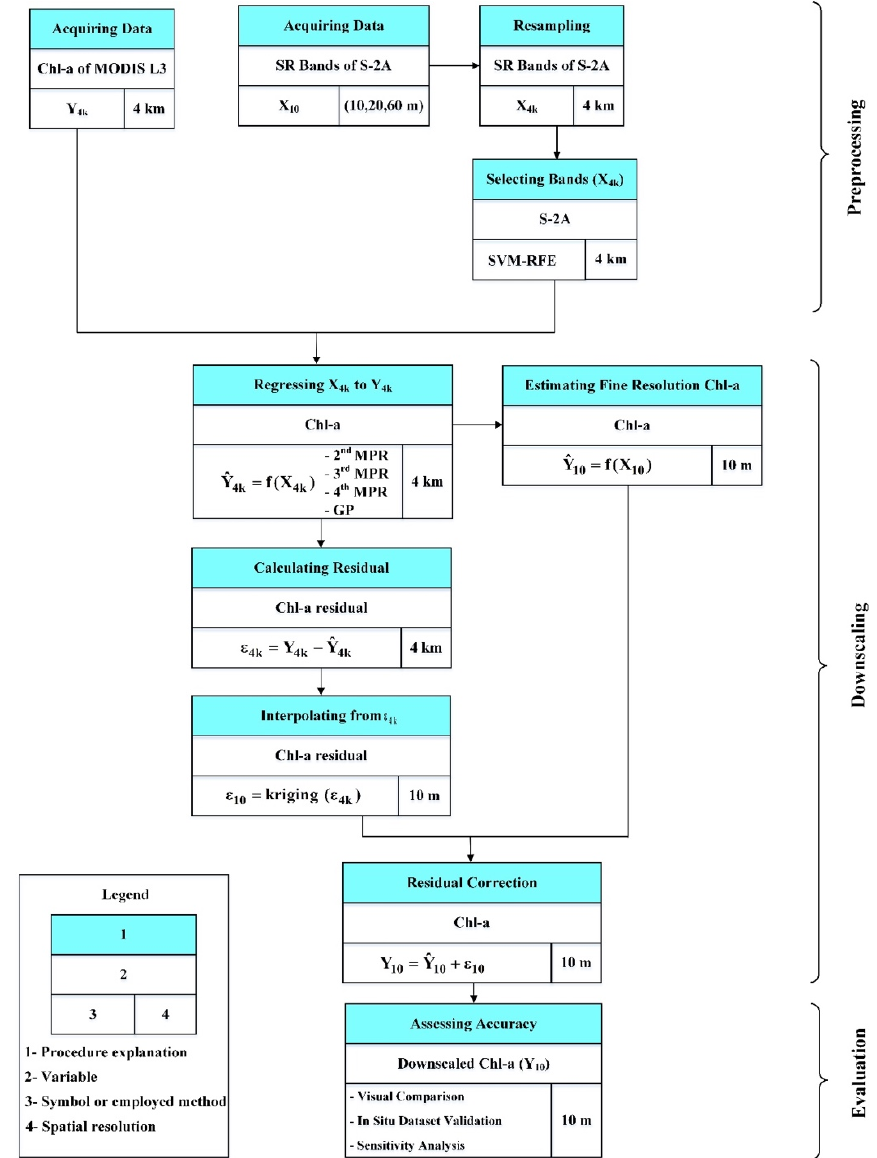
Figure 2. Downscaling workflow. Note that the goal of the present research is to downscale Moderate Resolution Imaging Spectroradiometer (MODIS) Chl-a from coarse resolution (4 km) to high resolution (10